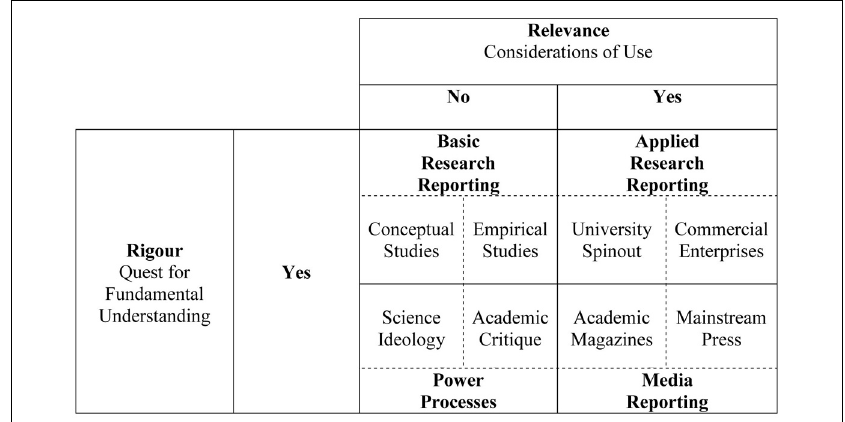
FIGURE 1 | Model of Co-Production in Organizational Cognitive